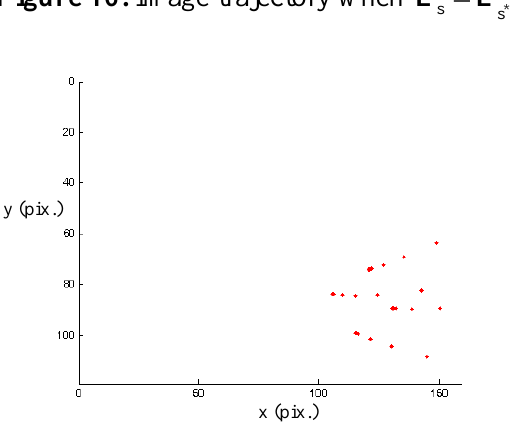
Figure 16. Image trajectory